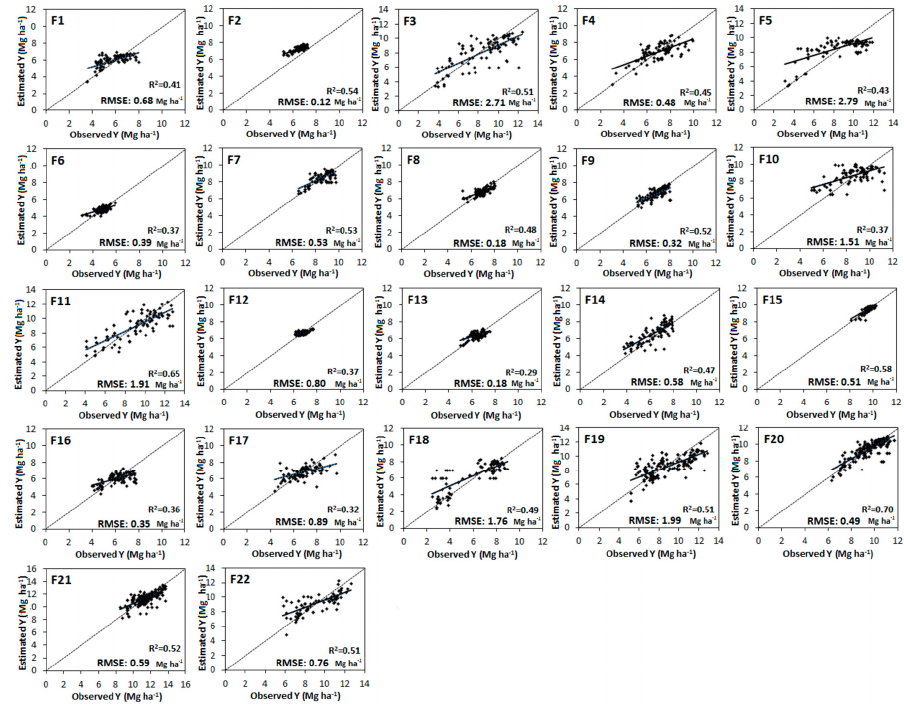
Figure 2. Estimated (predicted via mid-season high-resolution satellite imagery) versus observed corn yield, Y (end-season yield monitor data), 155 g · kg − 1 grain moisture content, expressed in Mg · ha − 1 . Coefficient of determination (R 2 ) and root mean-square error (RMSE) was calculated for each field relationship. A dashed line is presented in each panel portraying the 1:1 line for the estimated–observed yield